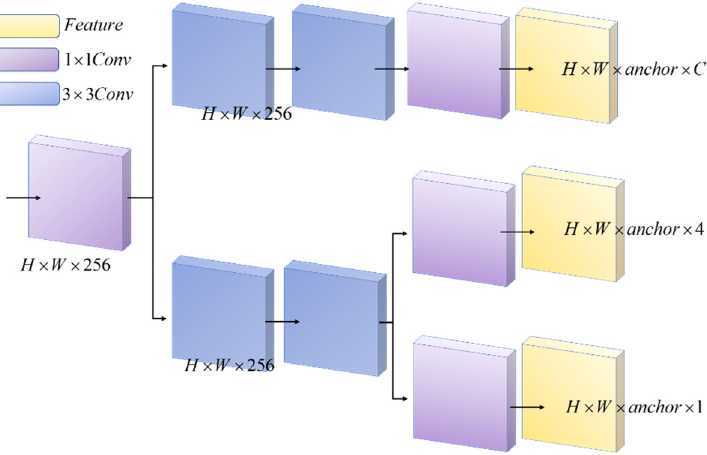
Figure 4. Structure of Decoupled